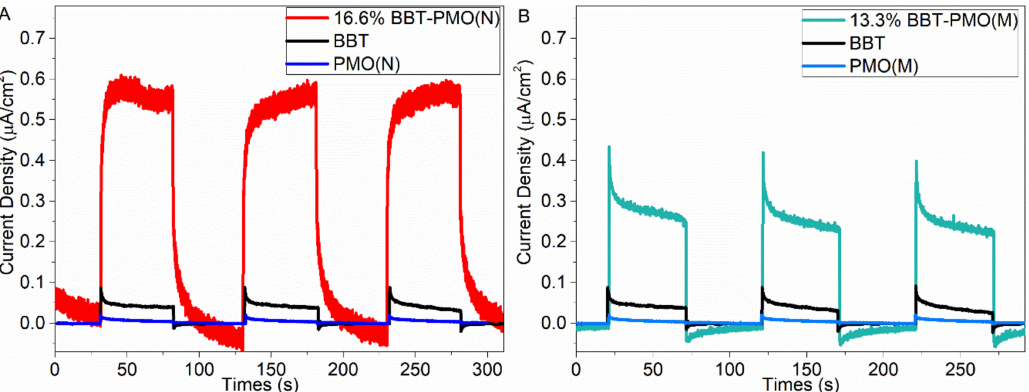
Figure 7. Photocurrent measurement of ( A ) BBT, PMO(N) and 16.7% BBT-PMO(N), and ( B ) BBT, PMO(M) and 13.3%